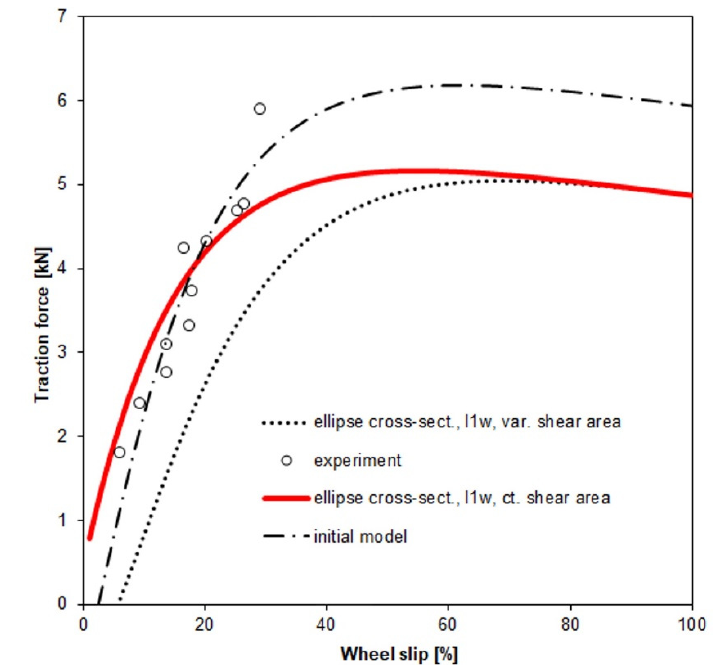
Figure 5. Traction force of the 2 WD tractor with 65 HP.